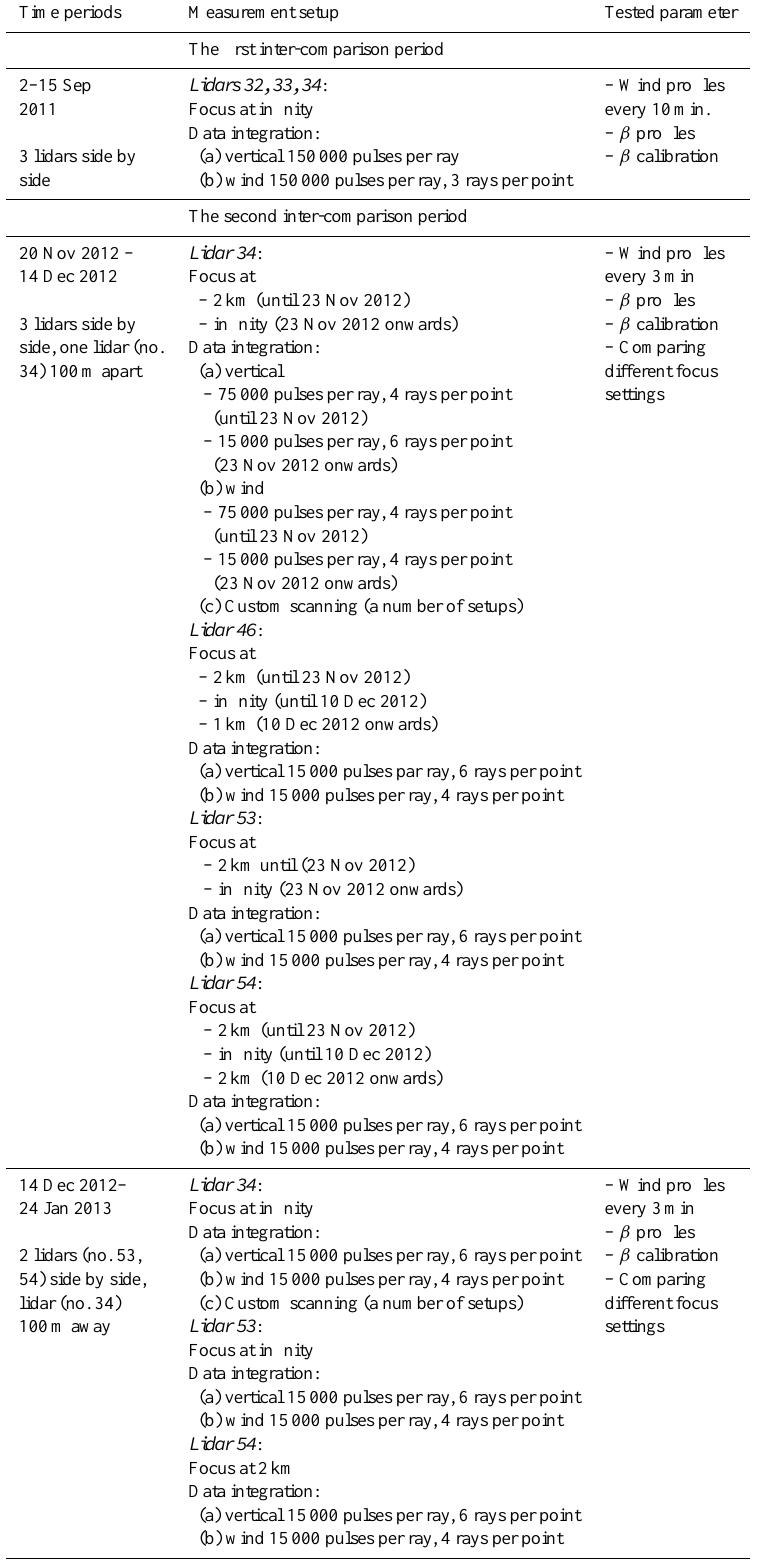
Table 3. Details of Doppler lidar inter-comparison campaigns periods analysed in this work. A ray means one profile. Three rays per point means that data collected during three subsequent profile measurements to the specific measurement direction were taken into account to get one